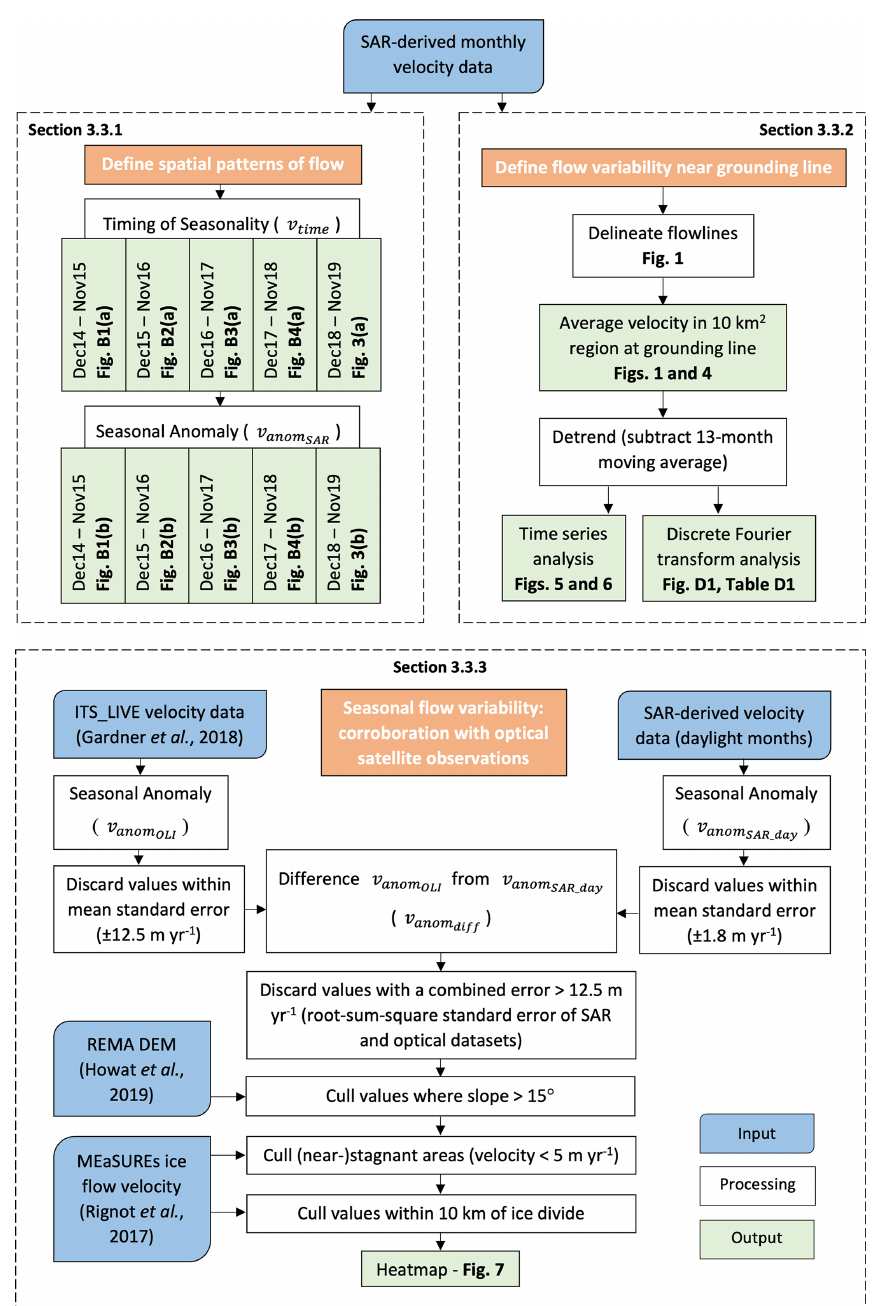
Figure 2. Workflow detailing the establishment of spatial patterns of flow (Sect. 3.3.1), the assessment of flow variability near the grounding line (Sect. 3.3.2), and the corroboration with optical satellite observations (Sect.